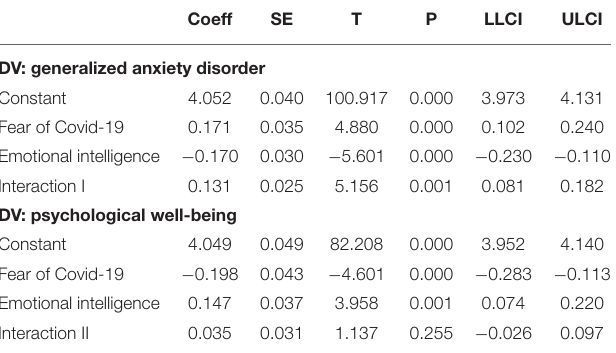
TABLE 4 | Direct and moderating